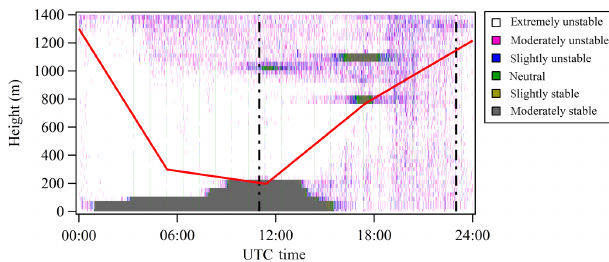
Figure 2. Vertically and temporally resolved atmospheric stability on 12 May 2013 at SGP. The atmospheric stability is classified into extremely unstable (white), moderately unstable (magenta), slightly unstable (blue), neutral (green), slightly stable (brown), and moder- ately stable (grey) regimes based on Richardson number. The two vertical dashed lines represent 06:00 and 18:00 local time, respec- tively. The red line shows the boundary layer height determined from radiosonde